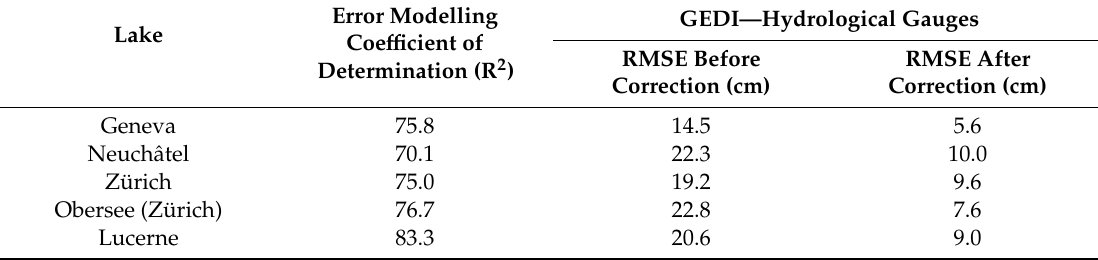
Table 6. Accuracy of elevations from GEDI acquisitions for each of the 5 lakes without and with accounting for the sources of error (RMSE), using data from all acquisition dates given in Table 1 and from all the